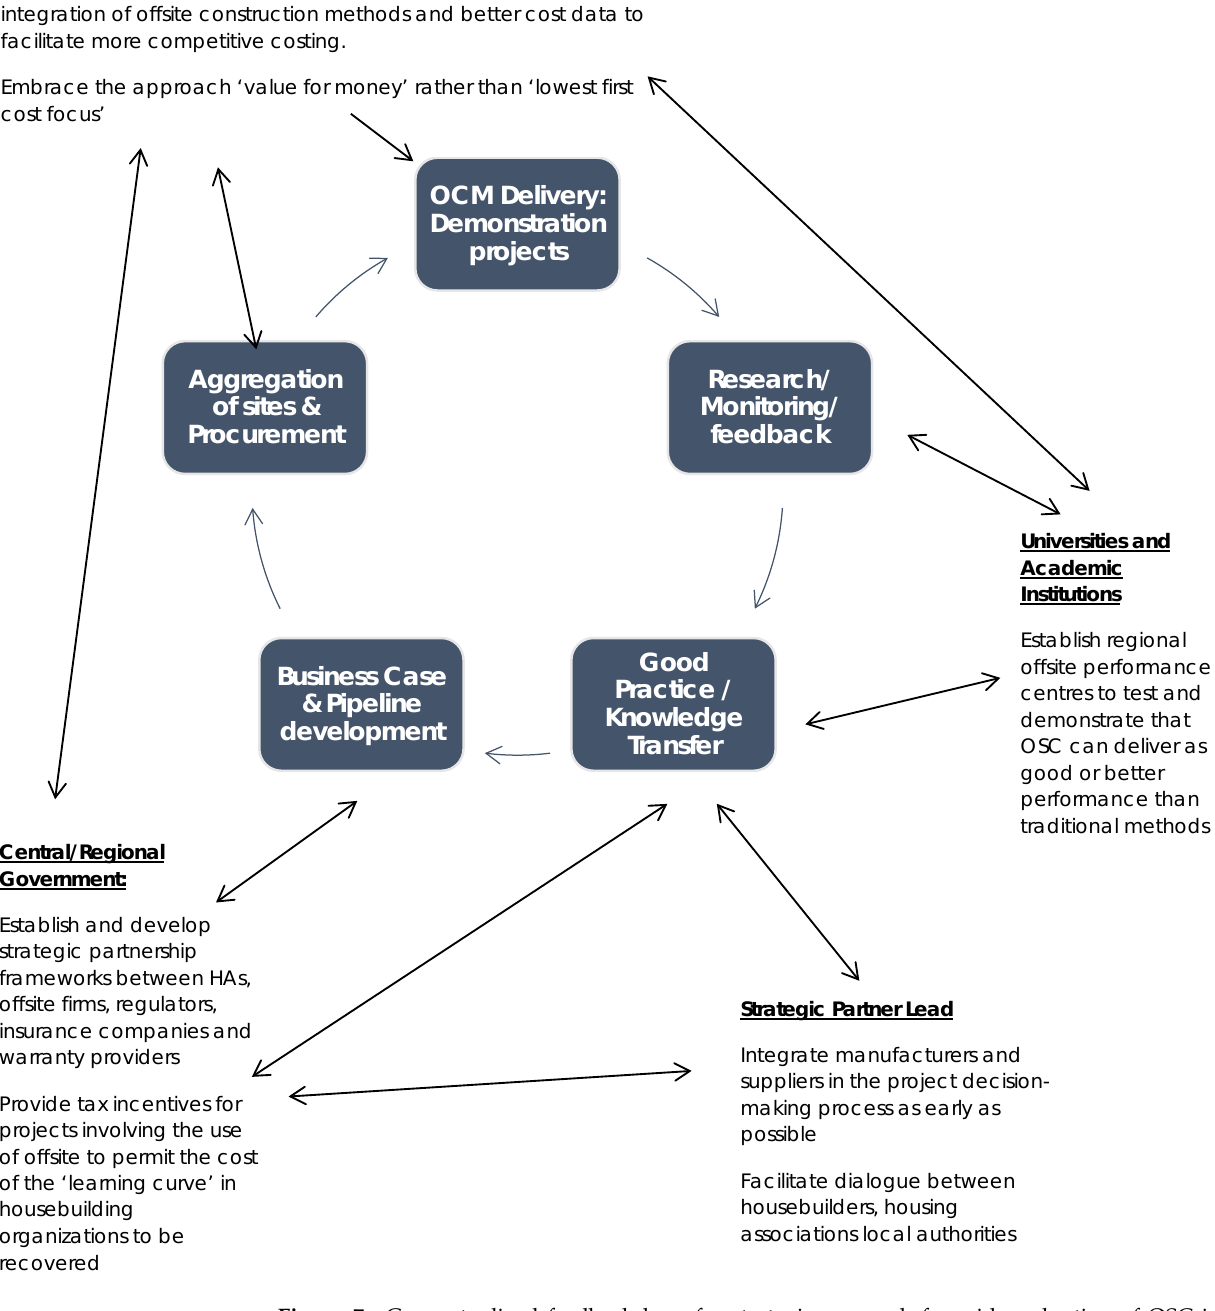
Figure 7. Conceptualized feedback loop for strategic approach for wider adoption of OSC in the HA sector